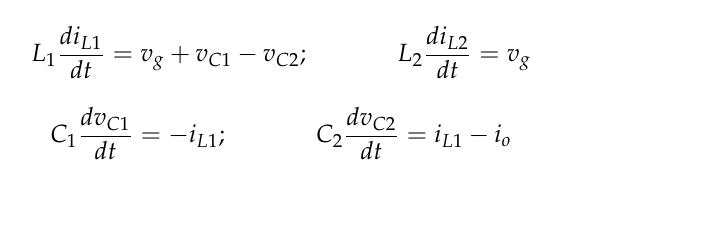
Figure 6. Equivalent circuit according to the switching state ( a ) s 1 = 1 and s 2 = 0, ( b ) s 1 = 0 and s 2 = 1, and ( c ) s 1 = 1 and s 2 = 1. In addition, ( d ) shows the time period of PWM signals (zoom intro signals in Figure 5c).